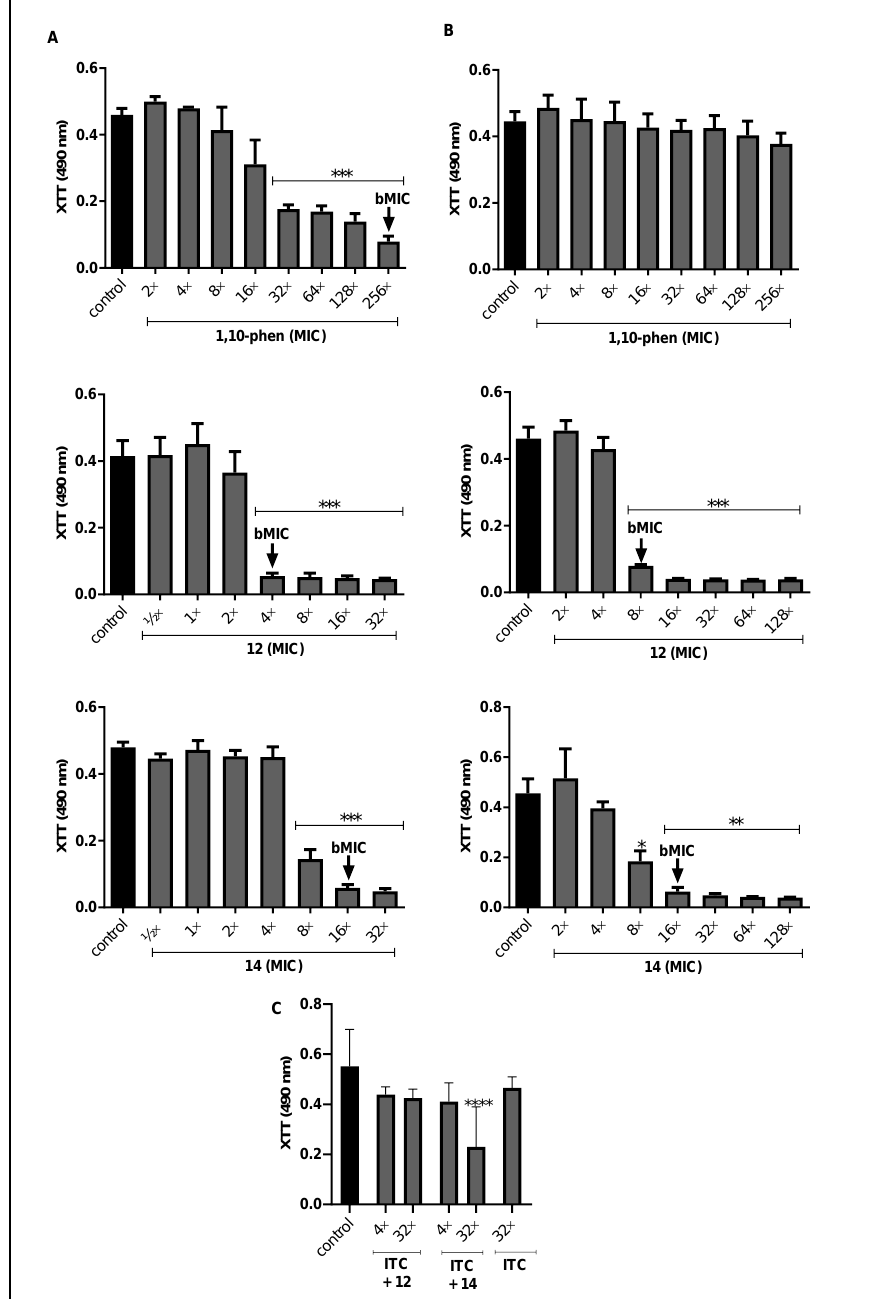
Figure 1. Effect of phen and its silver complexes on the viability of F. pedrosoi biofilm formation and maturation. ( A ) In a 96-well polystyrene microplate, conidia were treated immediately with different concentrations of phen and its silver complexes, and incubated in RPMI medium for 72 h at 37 ◦ C; ( B ) Conidia were added in another microplate to form biofilm and, just after 72 h, the test compounds were supplemented and the systems incubated for an extra 48 h; and ( C ) Conidia were incubated for 72 h with a combination of non-inhibitory concentrations of itraconazole and the complexes 12 (2 × MIC) and 14 (4 × MIC). The cell viability and the minimum inhibitory concentration values of fungal biofilms (bMIC) were assessed using XTT reduction assay after reading at 490 nm [52]. Non-treated conidia were also included as control systems. * p < 0.05, ** p < 0.01, *** p < 0.001, **** p <